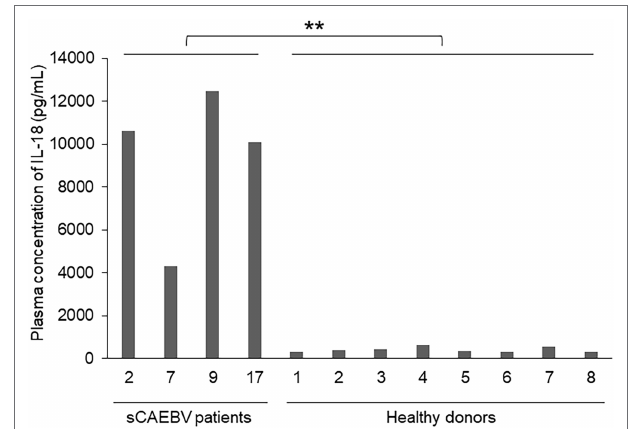
FIGURE 4 | The concentrations of IL-18 in the plasma of sCAEBV patients. The concentrations of IL-18 in the plasma of four sCAEBV patients and eight healthy donors were measured by U-PLEX Human IL-18 Antibody. There were significant differences between IL-18 plasma concentration in patients with plasma IL-1 β and healthy donors (** p <